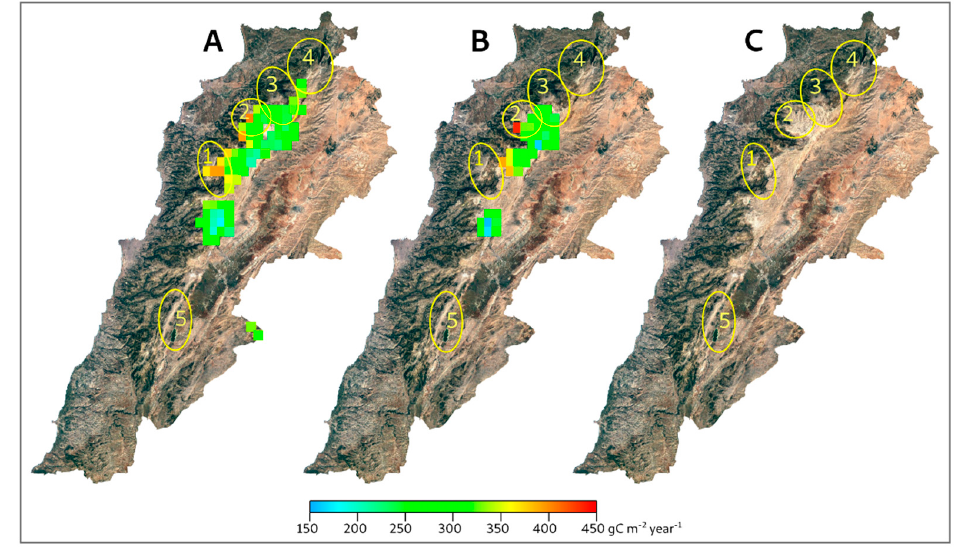
Figure 5. Five sectors (1 to 5) of priority populations for conservation with predicted potential occurrence of Cedrus libani (in terms of predicted net primary productivity in grams of carbon per meter square and per year (gCm − 2 year − 1 )) simulated under three different IPCC climate scenarios of atmospheric CO 2 concentration [10] ( A ) B1 with 500 ppmv, ( B ) A1B with 660 ppmv and ( C ) A2 with 750 ppmv.